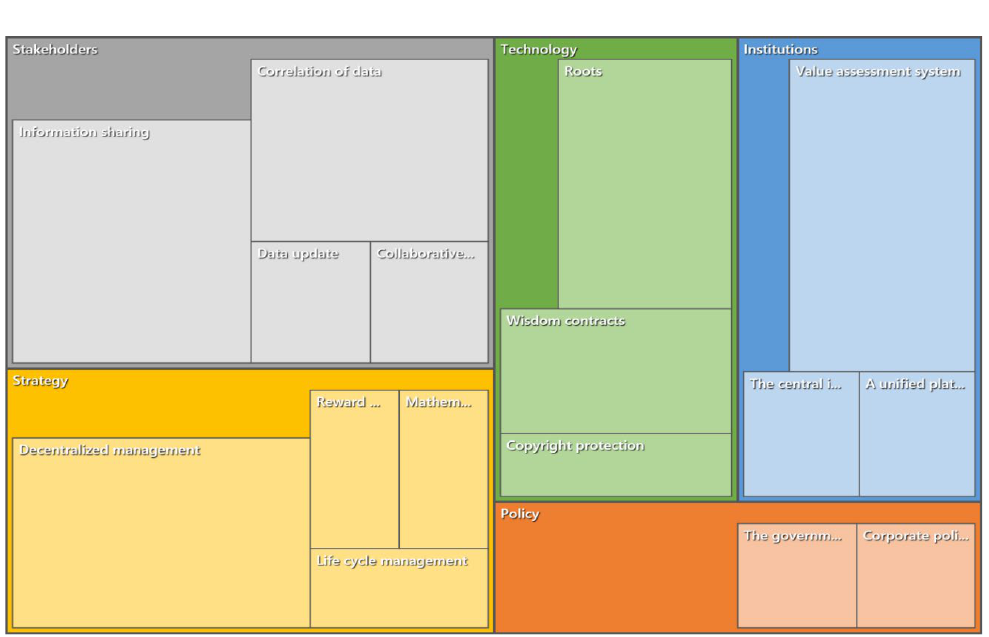
Figure 12. Node distribution (exported from NVivo 11 software).